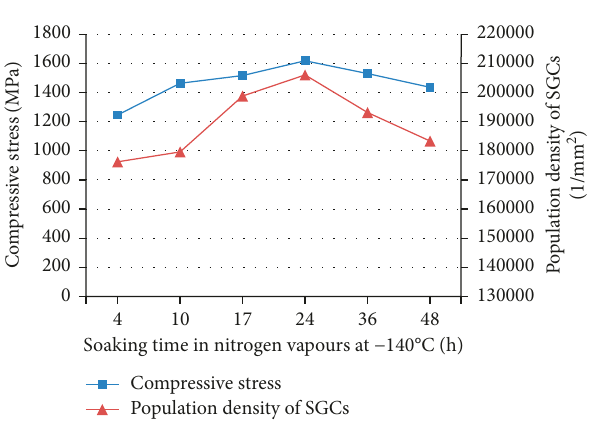
Figure 6: Dependence of the population density of SGCs and compressive stress in the retained austenite for specimens pro- cessed for various soaking times, at a temperature of